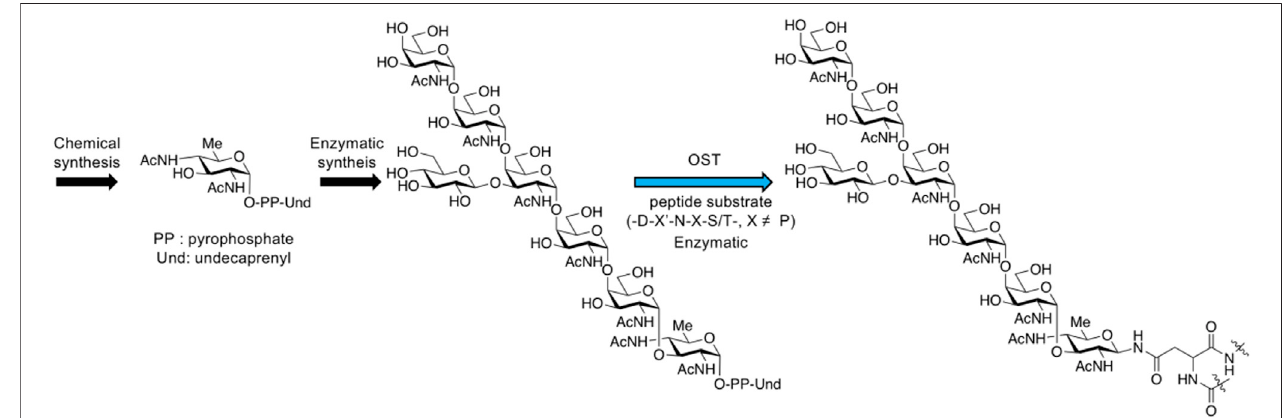
FIGURE 16 | N -glycan synthesis through bacterial biosynthesis including oligosaccharyltransferase